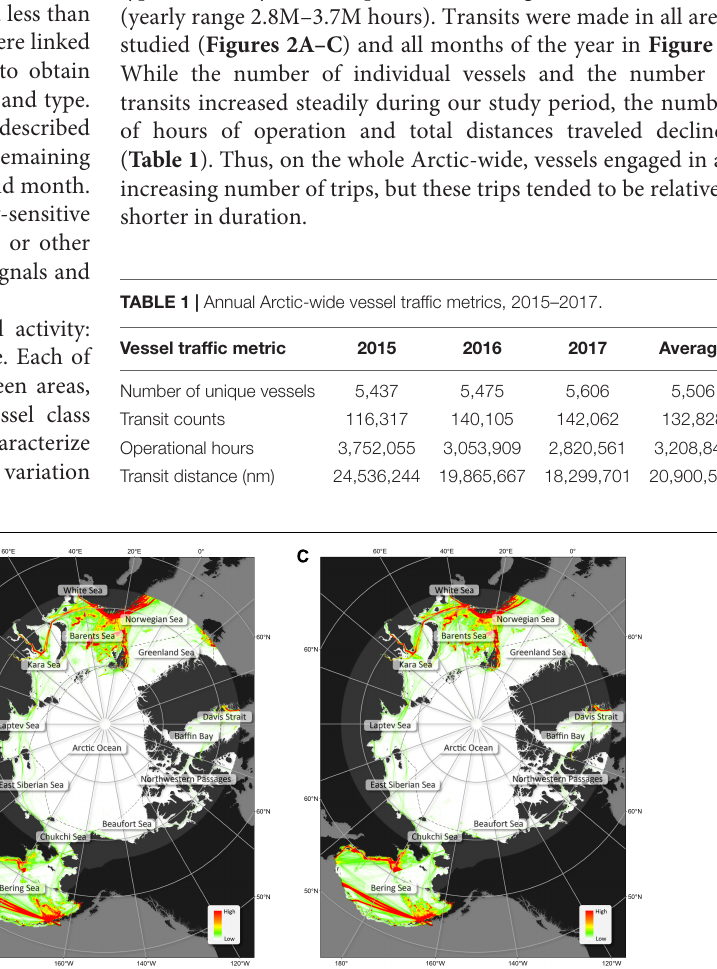
Frontiers in Marine Science |